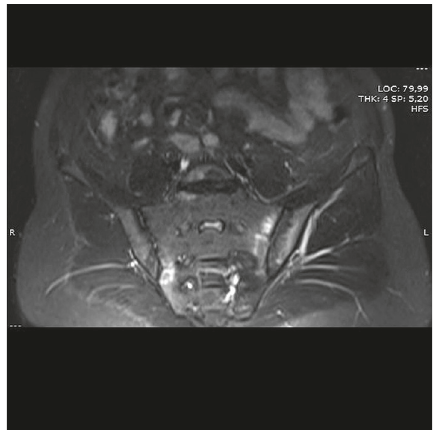
Figure 1: Coronal gadolinium-enhanced fat-suppressed T1- weighted MRI scan of the sacroiliac joints showing chronic de- generation and acute sacroiliitis.